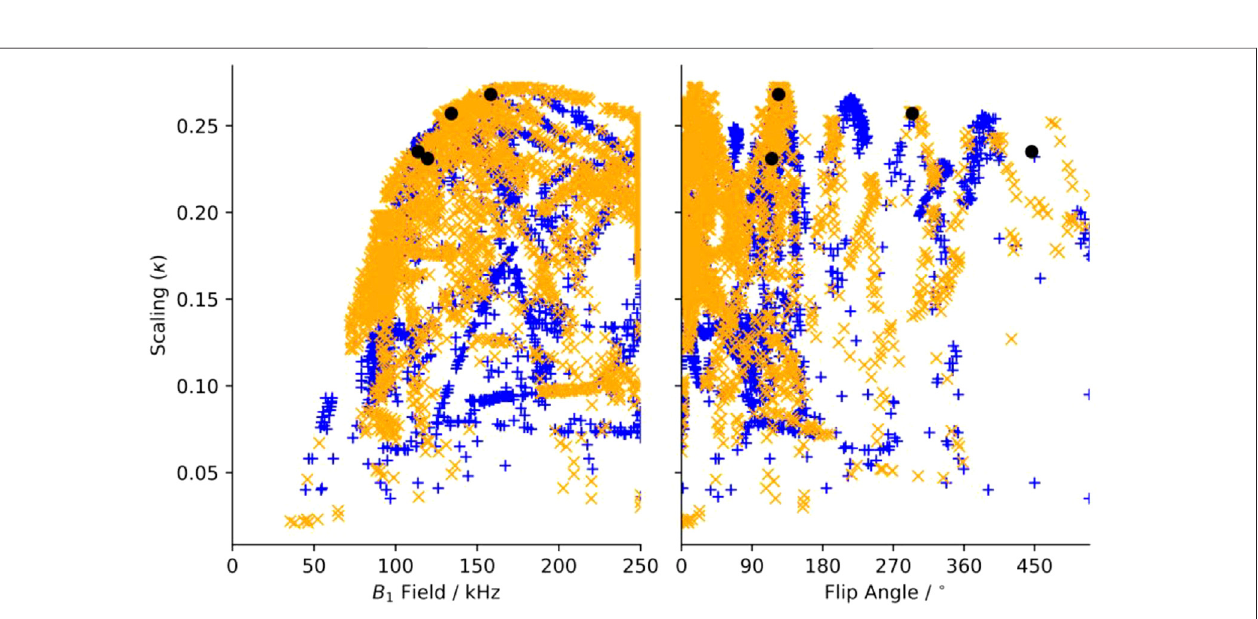
FIGURE 3 | Maximum scaling factor for heteronuclear dipole-dipole scaling factor determined in silico of all test symmetries and pulse sequence elements as a function of (a) applied (B 1 ) fi eld and of additional tilt angle ( θ ). Blue “ + ”’ s indicate sequences where “ m ” and “ μ ” are correlated, and orange “ x ” s are anti-correlated. Black circles indicate the position of sequences chosen for experimental veri fi